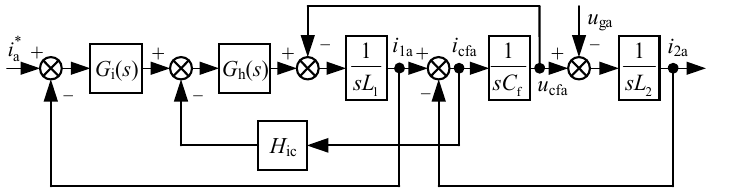
Figure 2. Conventional indirect current control block of the LCL-type grid-connected inverter.